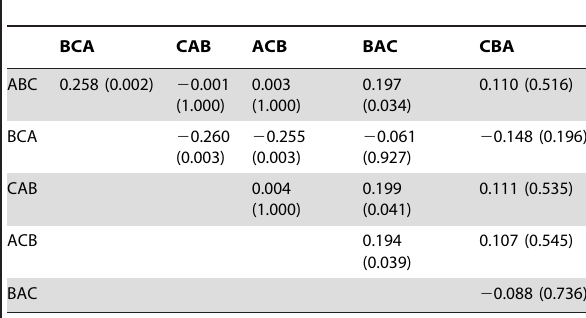
Table 3. Mean community dispersion (Bray-Curtis distances and corresponding p-values) from Tukey’s HSD tests for comparisons of the sequence treatments corresponding to the six possible orders of introduction of experimental species A, B, and C into the